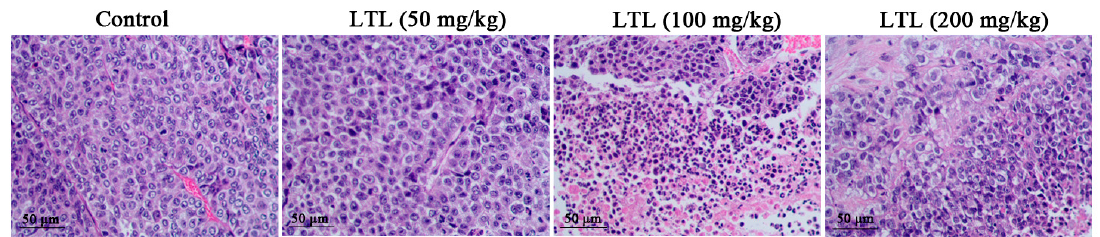
Figure 3. Histological analysis of tumor samples after LTL administration.